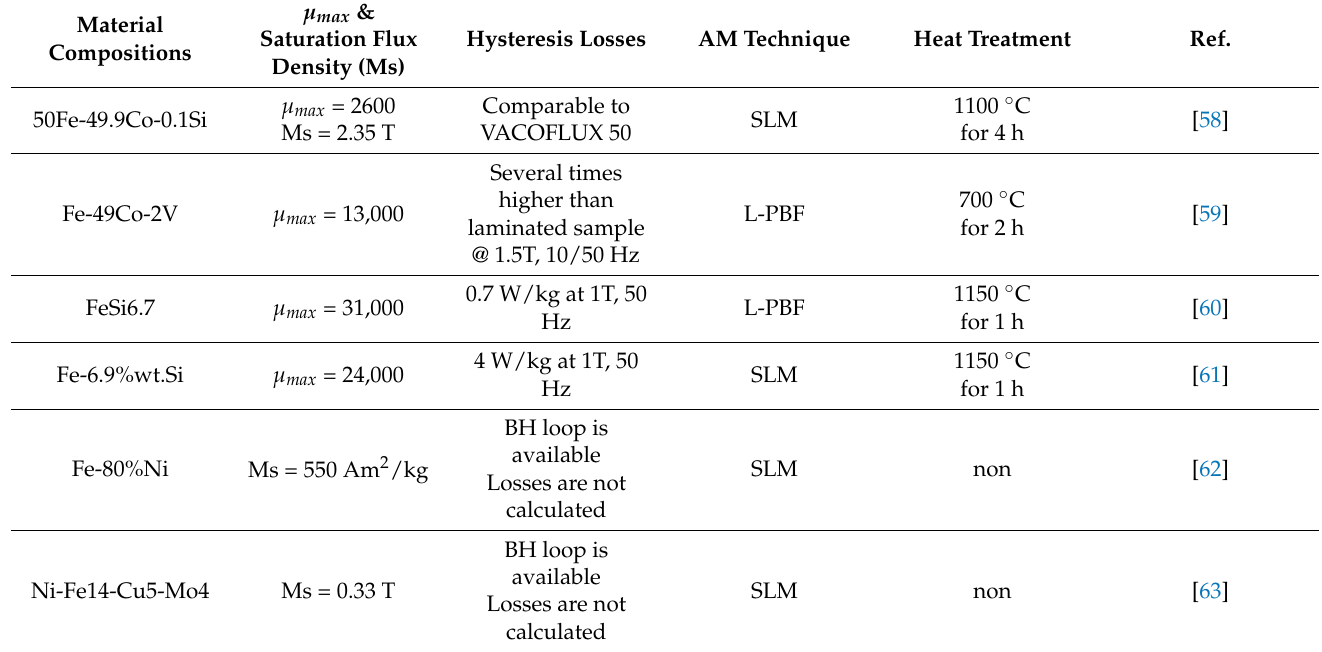
Table A1. Magnetic properties of different AM soft magnetic